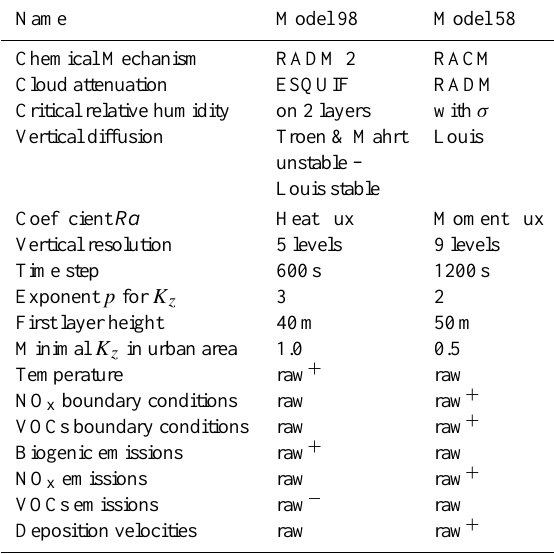
Table 7. A comparison between the model 98 and